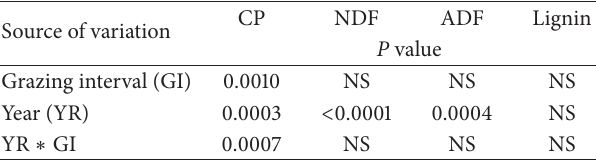
Table 7: Analysis of variance for crude protein (CP), neutral detergent fiber (NDF), acid detergent fiber (ADF), and lignin as a function of grazing interval and year and their interaction.